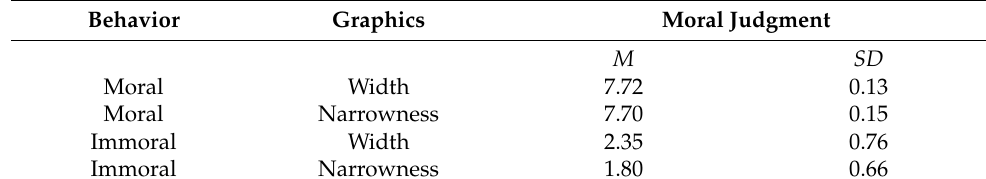
Figure 9. Example of event sequences on moral judgment task in Experiment 3a. Table 4. Mean rating of moral judgment under different conditions (M ± SD).